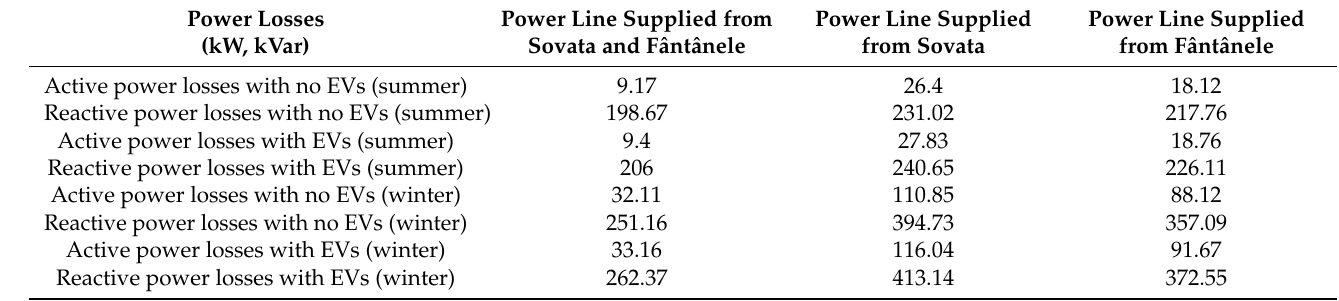
Table 25. Power losses at 16:00 (scenario